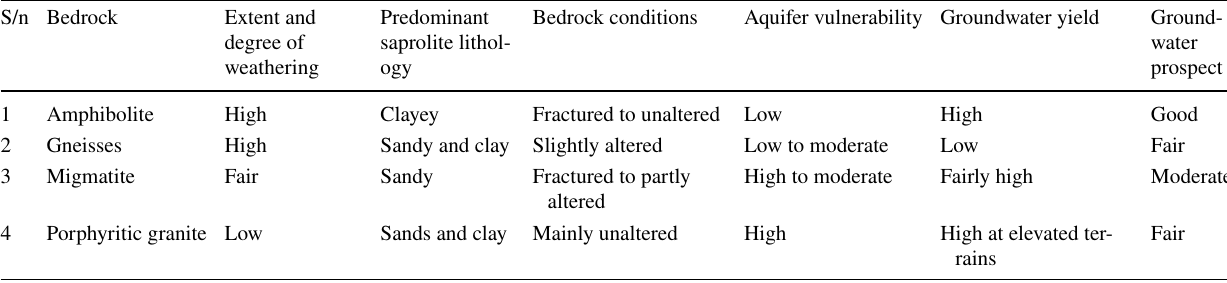
Table 6 Summary of hydrogeological characterisations of bedrock terrains at Ibarapa region S/n